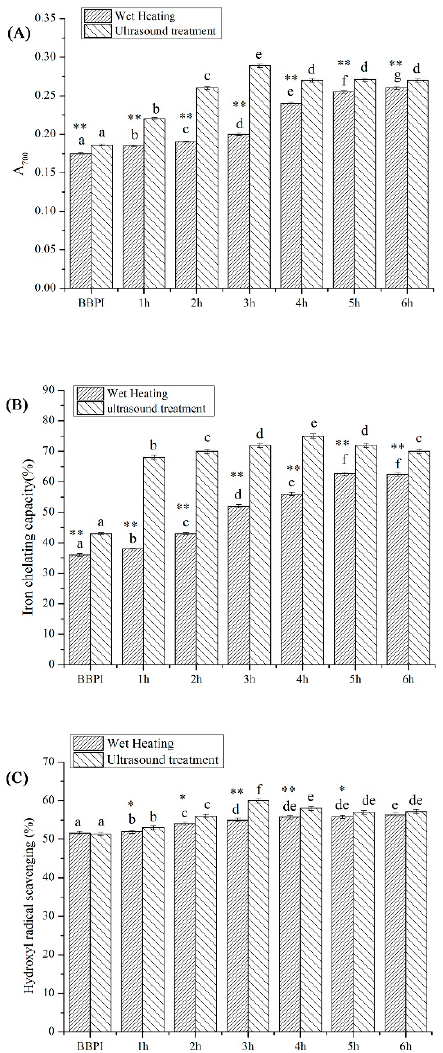
Figure 6. Antioxidant activity of BBPI by wet heating and ultrasound treatment Maillard reaction obtained after 1–6 h, respectively: ( A ) iron chelating capacity, ( B ) reducing power and ( C ) hydroxyl radical scavenging activity. Means with dissimilar lower-case letters indicate significant differences ( P <0.05), ** means in the same time P < 0.01, * means in the same time P < 0.05.